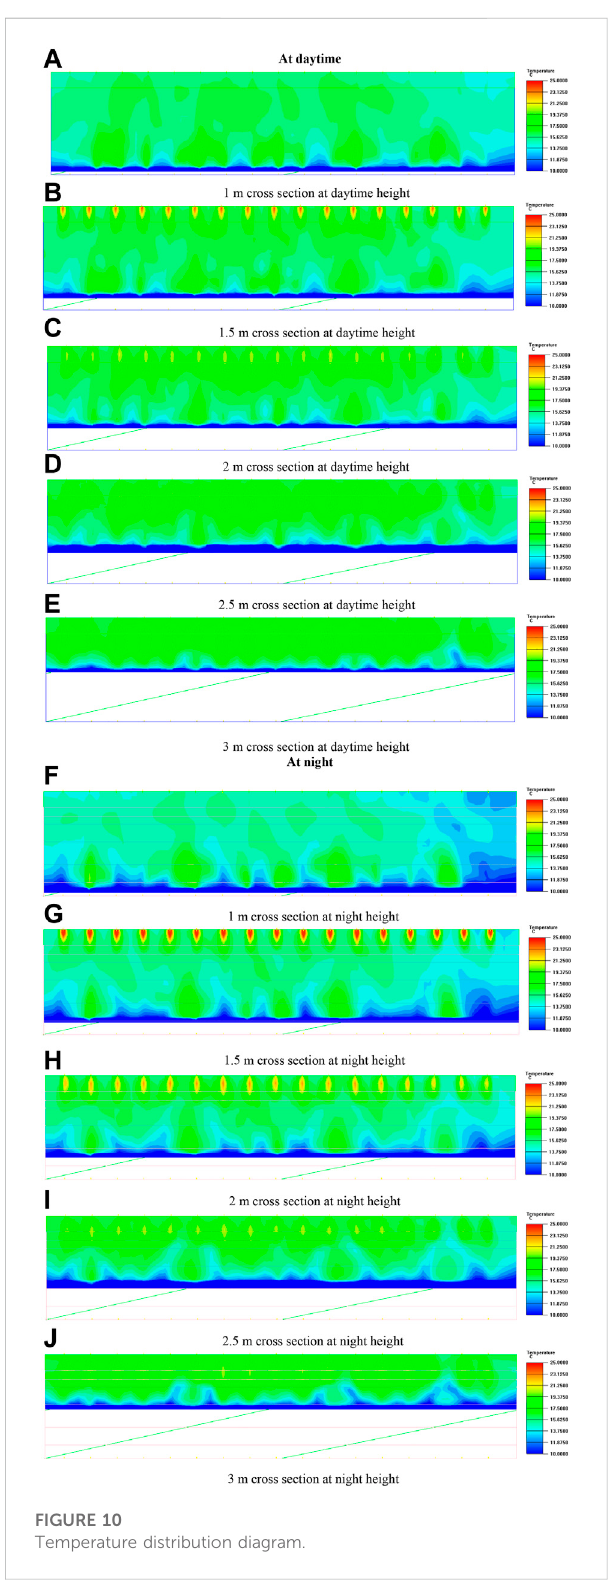
FIGURE 10 Temperature distribution